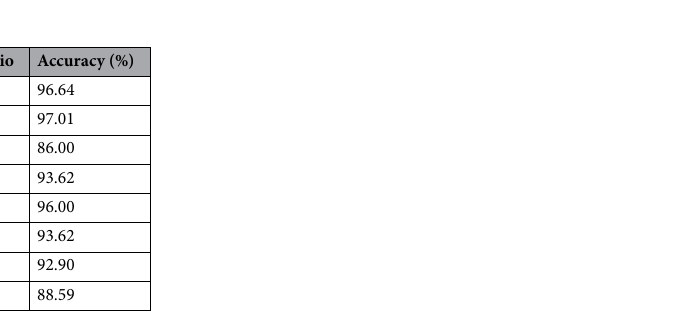
Figure 15. Comparison of the classifiers based on execution time of recognizing CoViD19+ve and CoViD19− ve.